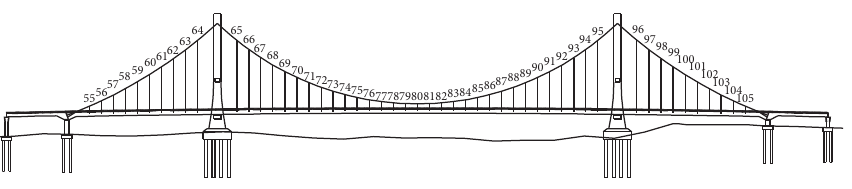
Figure 7: Suspenders and their associated